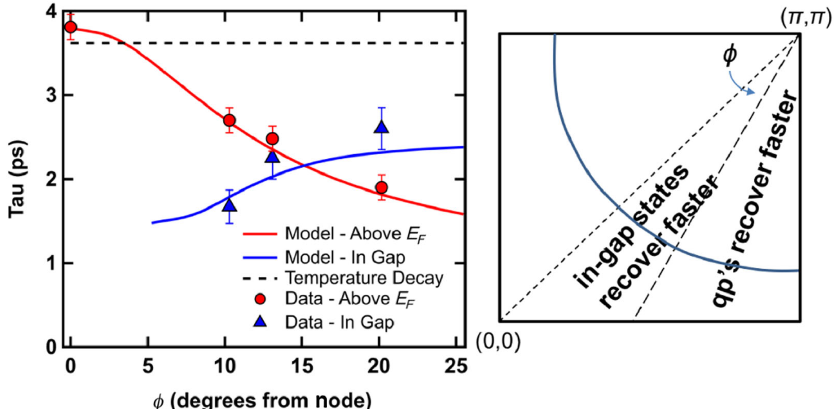
FIG. 6. The k -space crossover of gap dynamics. Both experimentally (circles and triangles) and theoretically (solid lines), we find that the near-nodal region is characterized by a faster recovery of in-gap states compared to those above E the reverse. This physics is driven by the interplay of different momentum and temperature-dependent pairing ( Δ ) and self-energy ( Γ ) scales. The Fermi surface locations of these regimes are shown in the right panel. The simulated decays (solid lines) represent a model of fully thermalized electrons, with a temperature decay measured via the node (black dashed line), which agrees well with the